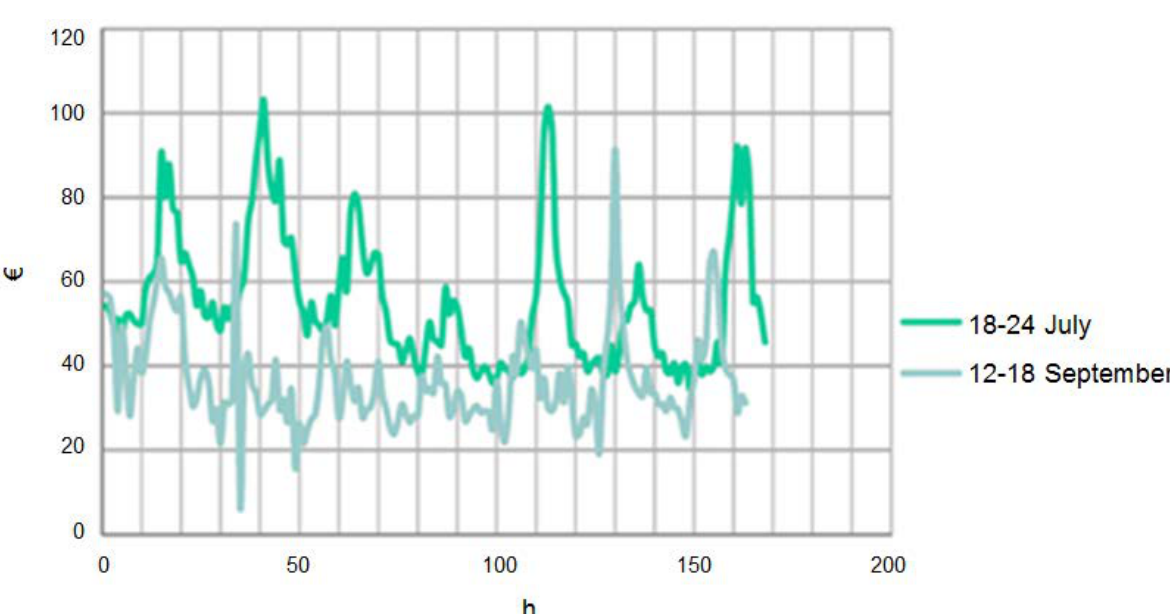
Figure 15. Cost of gas consumption (each